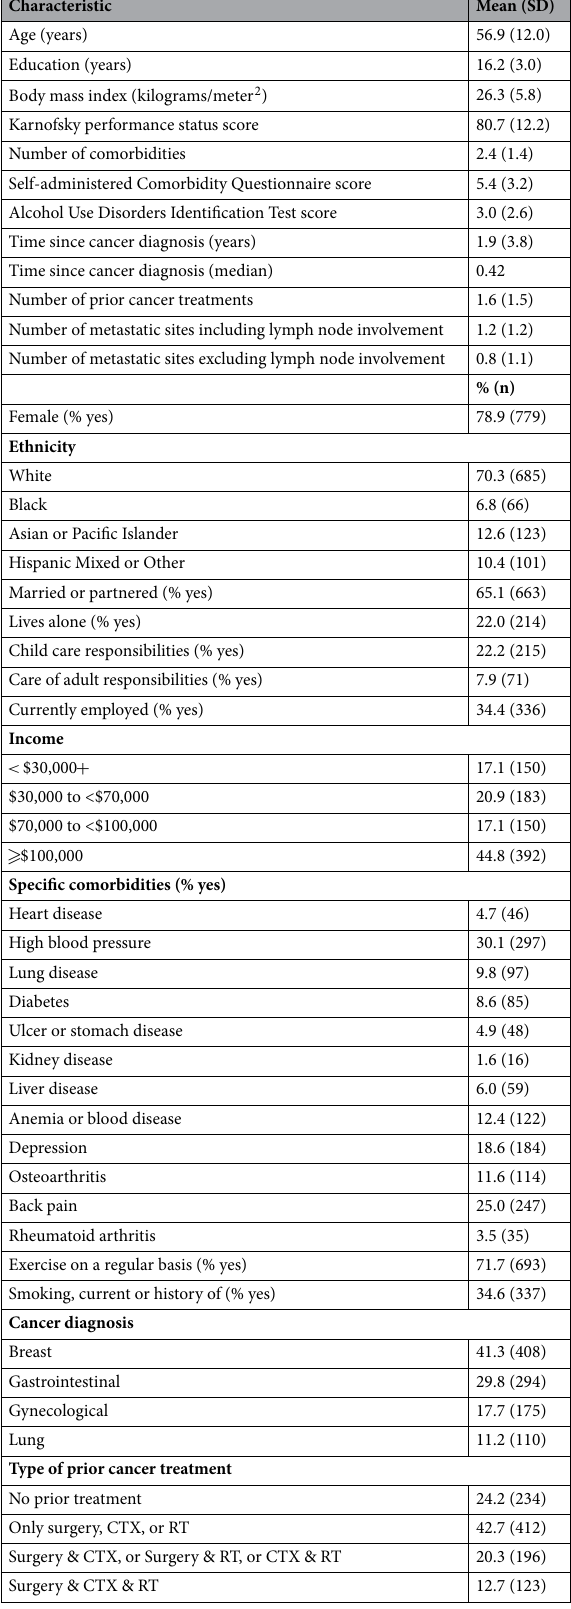
Table 4. Demographic and clinical characteristics of the total sample (n = 987). Abbreviations: CTX = chemotherapy, RT = radiation therapy, SD = standard